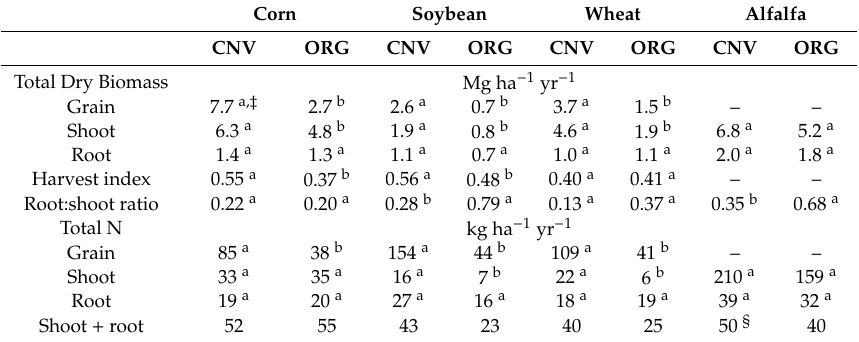
† Note: presented harvest index (HI) or root:shoot ratios do not conform to direct calculations from table data due to e n back transformation of LSMeans from a logN distribution analysis or with missing and unbalanced data; ‡ Lowercase letters within a row and crop indicate significant di ff erences between CNV and ORG ( p < 0.05); § Shoot + root for alfalfa includes only the 5% of shoot remaining in the field after